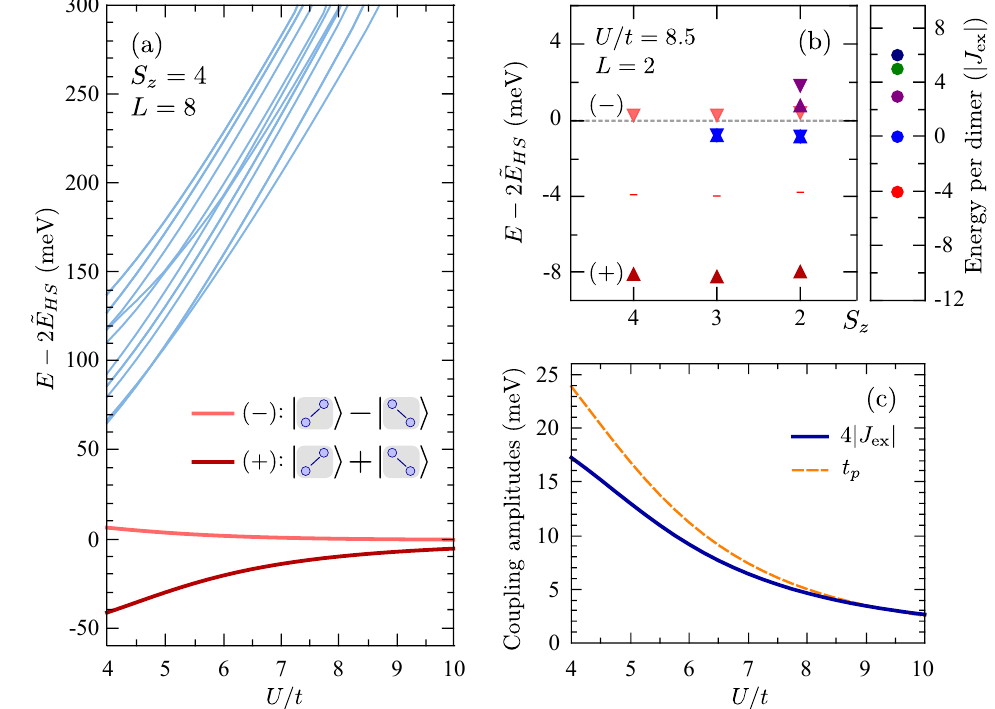
Figure 5: (a) Lowest eigenenergies for a two-HS configuration shown in Fig. 2(e) in = 4 and L = 8; (b) their spin-dependent structure for the reduced the subspace S z system size 2 × 2 sites compared to the eigenenergies of the two-site dimer in the spin-2 Heisenberg model with the FM coupling J t as functions of U / t p